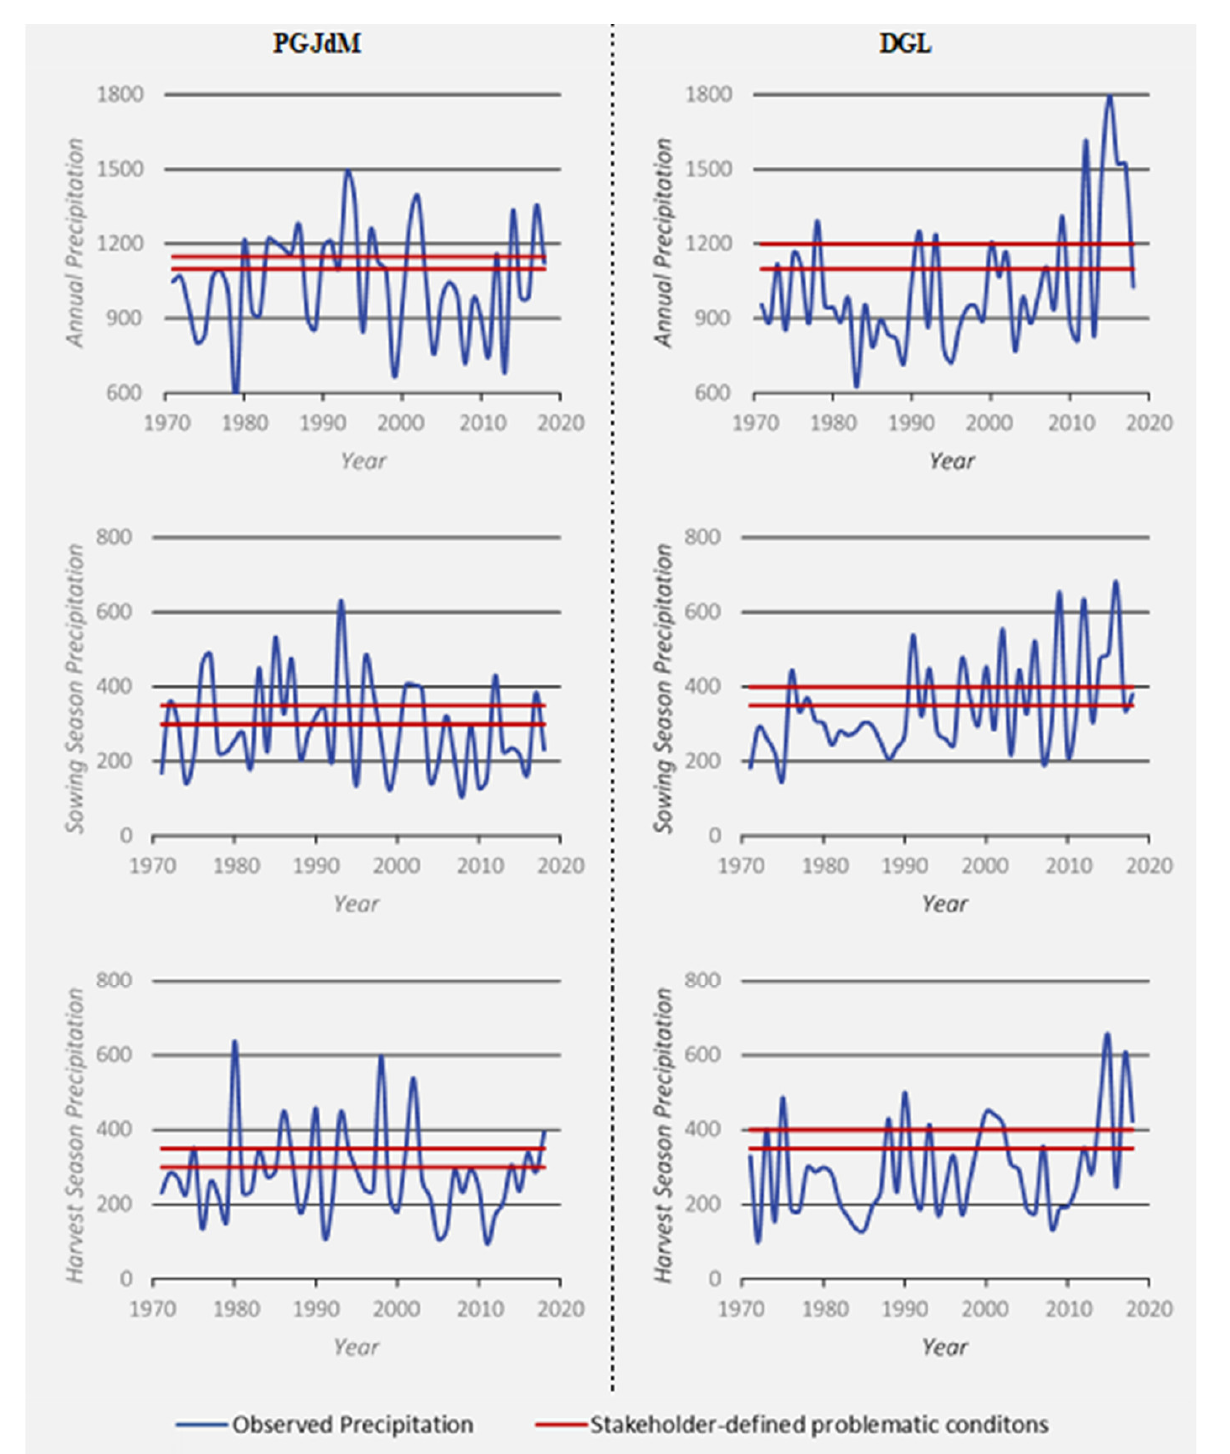
Figure A1. Historical precipitation data in the two case study locations in relation to soybean-producer-defined upper and lower thresholds.